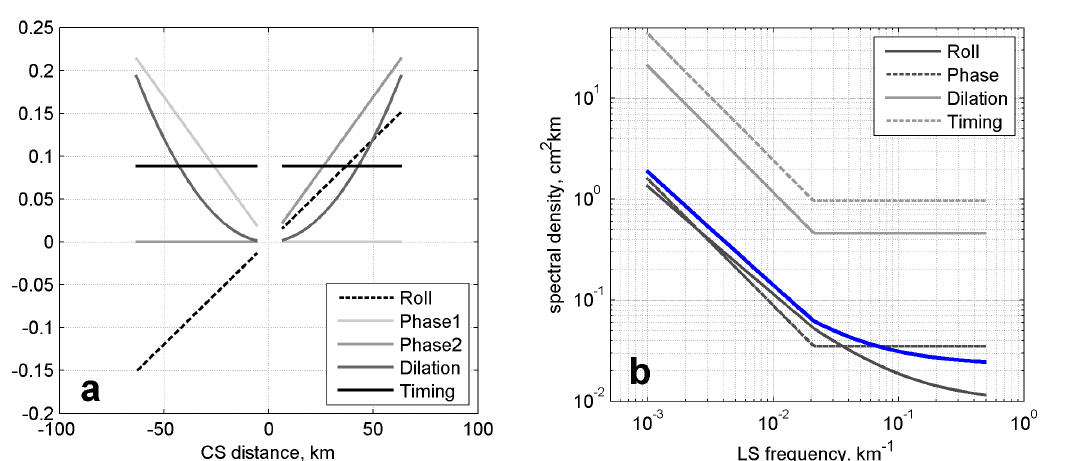
Figure 1. Parameters of the GOE covariance matrix of the SWOT simulator. ( a ): normalized CS structure functions; ( b ): square root of the LS error power spectra for a 1024 km long piece of swath. The magnitudes of dilation and timing errors are reduced by an order in magnitude for better viewing. The optimal universal spectrum is shown by the blue